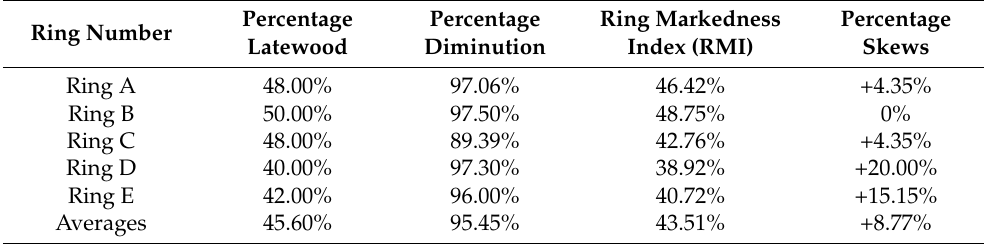
Table 2. Results of the quantitative growth ring analysis of Keteleerioxylon changchunense sp.